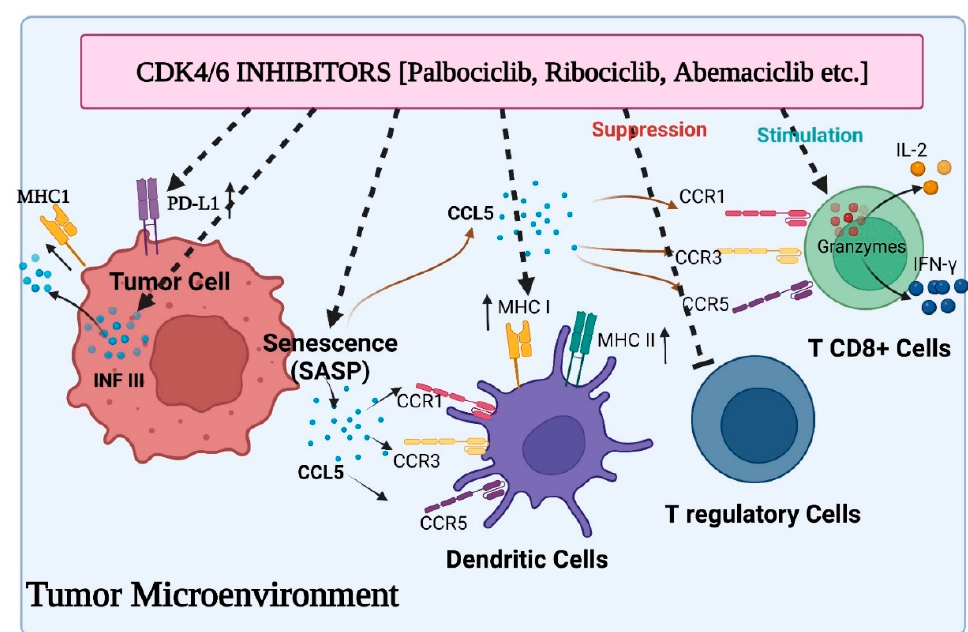
Figure 2. Various aspects of immunomodulation via CDK4/6 inhibitors on the tumor microenviron- ment: induced activity of antigen presentation and PD-L1 expression on tumor cells, suppressed activity of Treg cells, enhanced cytokine secretion from CD8+ T cells and stimulated function of antigen presentation by dendritic cells.